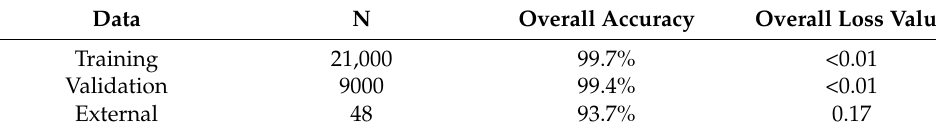
Table 2. Collection of data with associated overall accuracy and loss value.